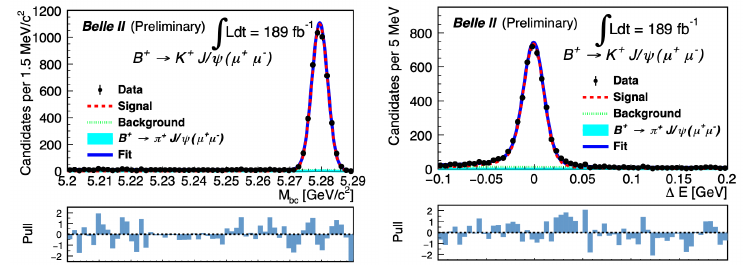
Figure 9. M bc (left) and ∆ E (right) distributions with the fit result superimposed. Black dots with error bars denote the data, blue curve denote the total fit, dashed red curves are the signal component, dotted green curves are the background component, and filled cyan regions are the B + → J /ψπ +